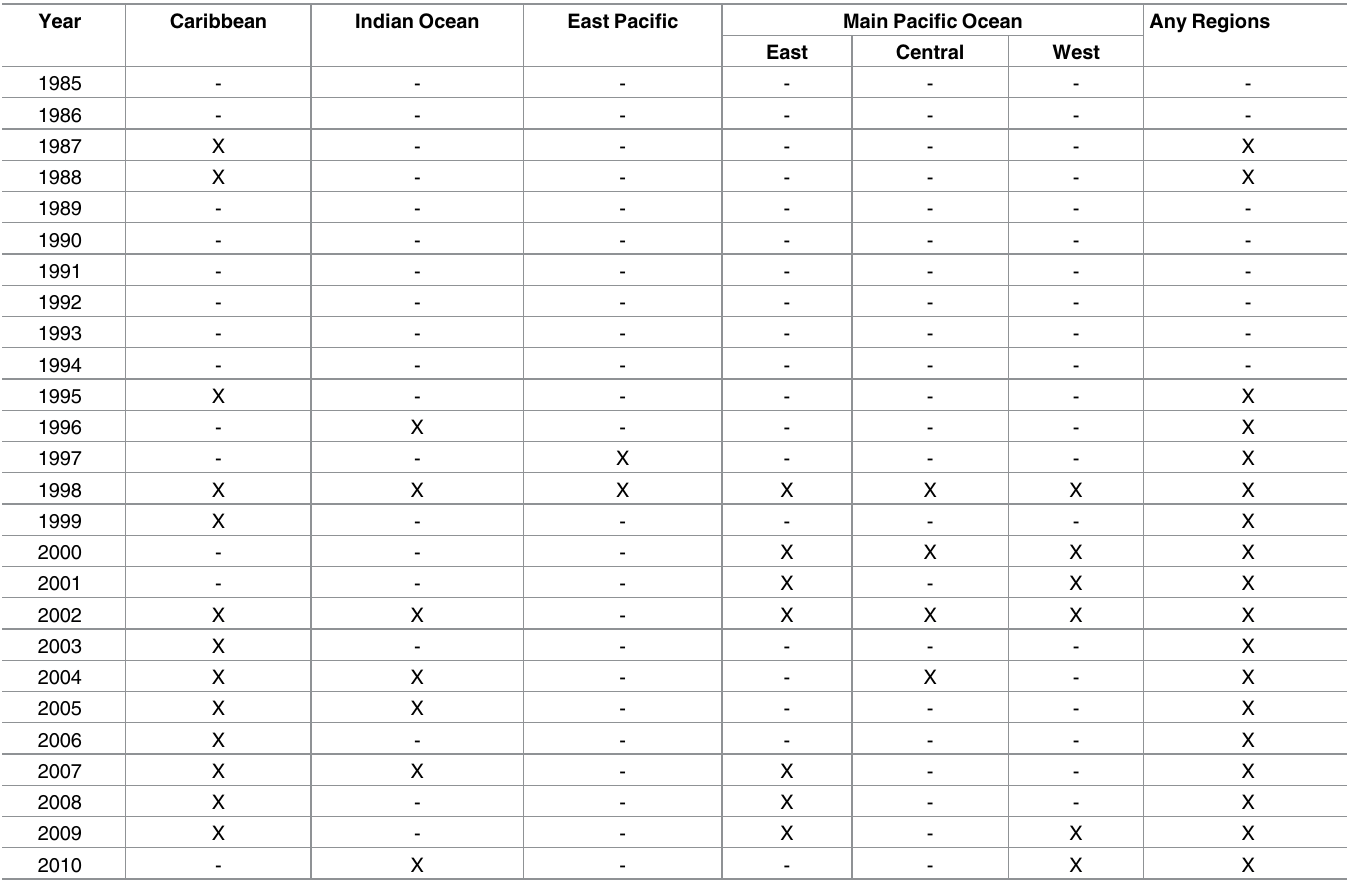
Table 4. Years for which indicator kriging was